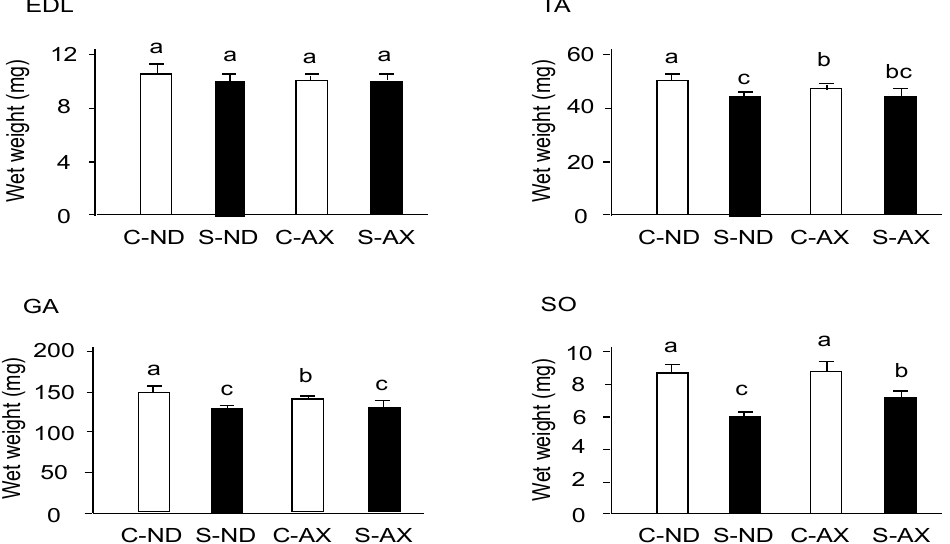
Figure 2. The effect of dietary AX on muscle mass in tail-suspension mice. An AX-supplemented or normal diet was given to the mice for 4 weeks and their skeletal muscles were isolated 2 weeks after tail suspension. The wet weights of the tibialis anterior, extensor digitorum longus, gastrocnemius, and soleus muscles were measured. Data are presented as mean ± S.D. ( n = 6). Different letters indicate significant differences ( p < 0.05) based on the two-way ANOVA and Tukey’s test. C-ND, control mice fed the normal diet; S-ND, tail-suspension mice fed the normal diet; C-AX, control mice fed the AX diet; and S-AX, tail-suspension mice fed the AX diet. TA, tibialis anterior muscle; EDL, extensor digitorum longus muscle; GA, gastrocnemius muscle, SO, soleus muscles.